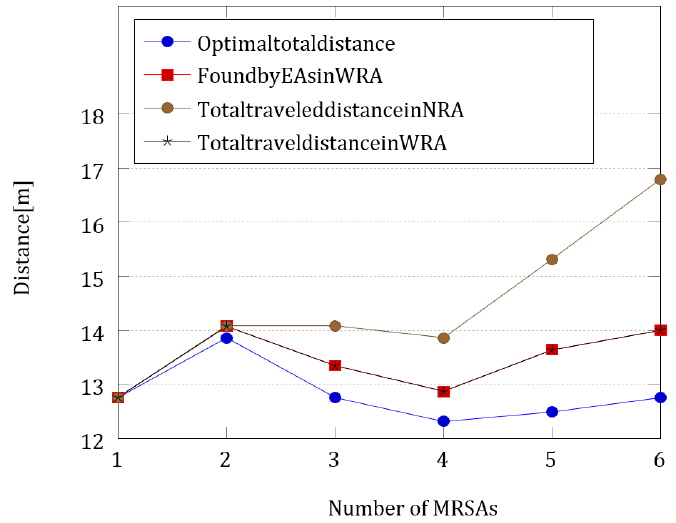
Figure 13. Comparison of the average distances.